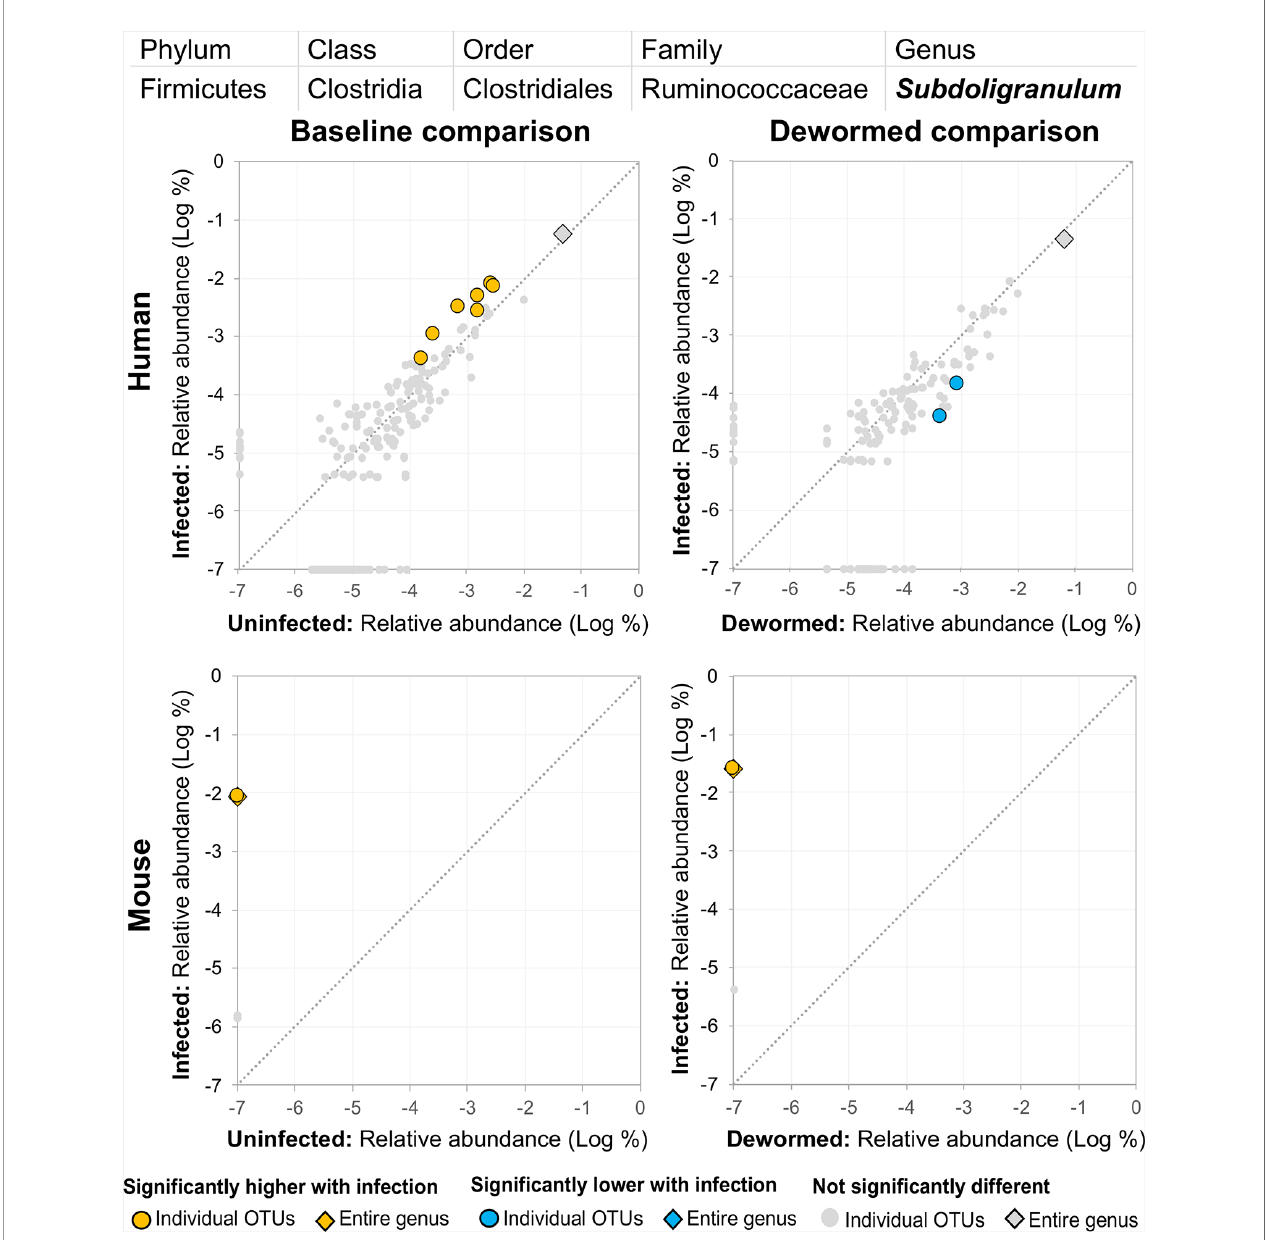
FIGURE 9 | The relative abundance (%) of all Subdoligranulum (genus) OTUs in each differential comparison among samples from whipworm-infected and uninfected humans and mice. Signi fi cant differentially abundant OTUs in each comparison (as identi fi ed by LEfSe) are colored in orange (higher with infection) and blue (lower with infection). The sum of all OTUs in the genus is represented with a diamond symbol. This is one of three genera with at least one OTU signi fi cantly higher in infection in three of four